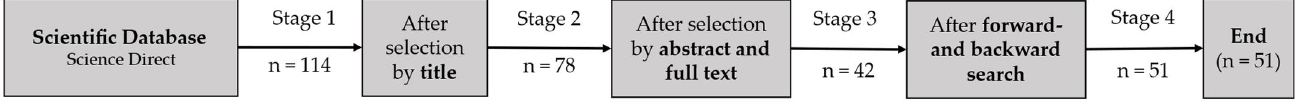
Figure 1. Selection procedure for the literature base.